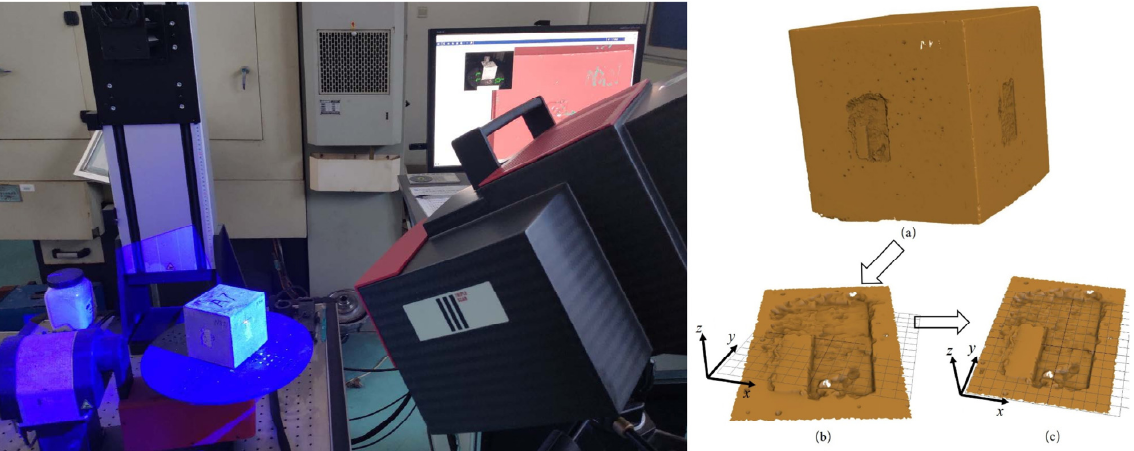
Figure 3. 3D laser scanner and data processing. ( a ) 3D image of the specimen surface ( b ) Data selection ( c ) Coordinate transformation.